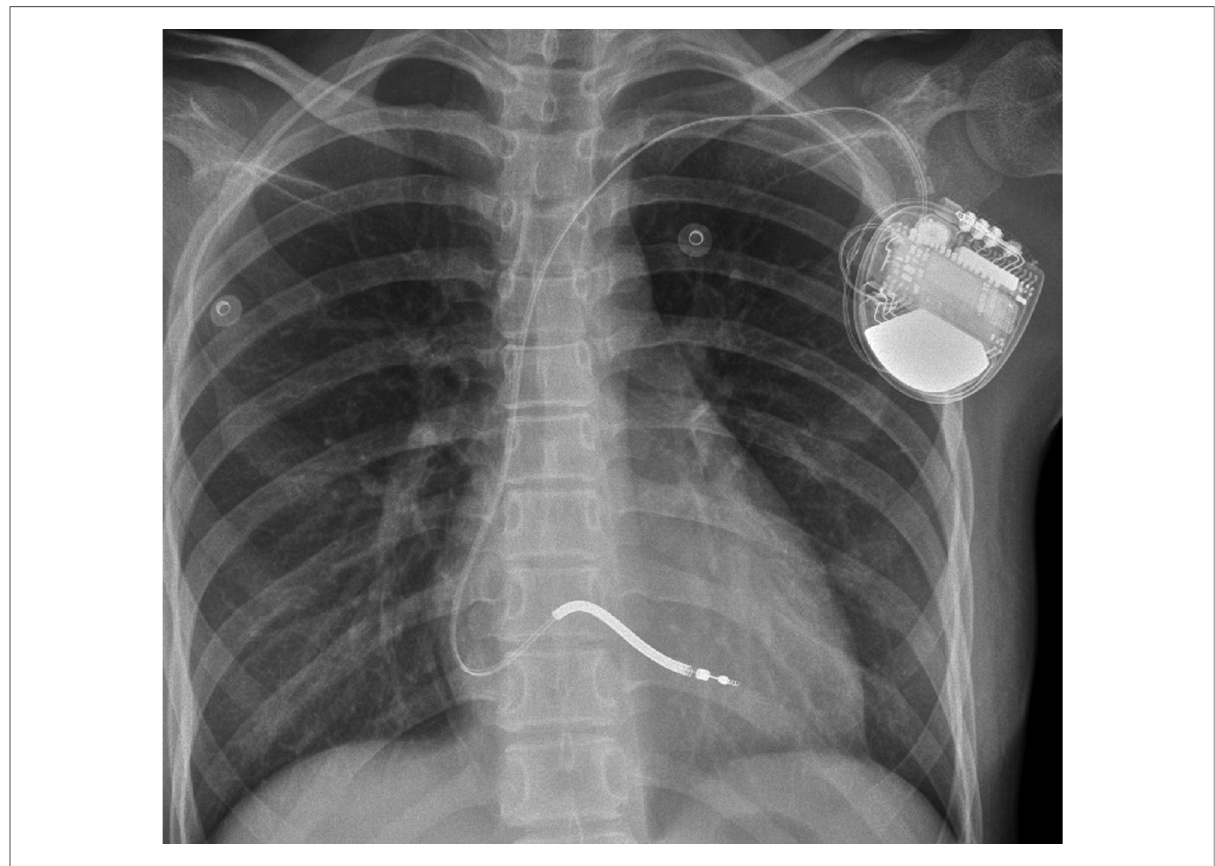
FIGURE 3 Chest x-ray after the implantation of the implantable cardioverter-de fi